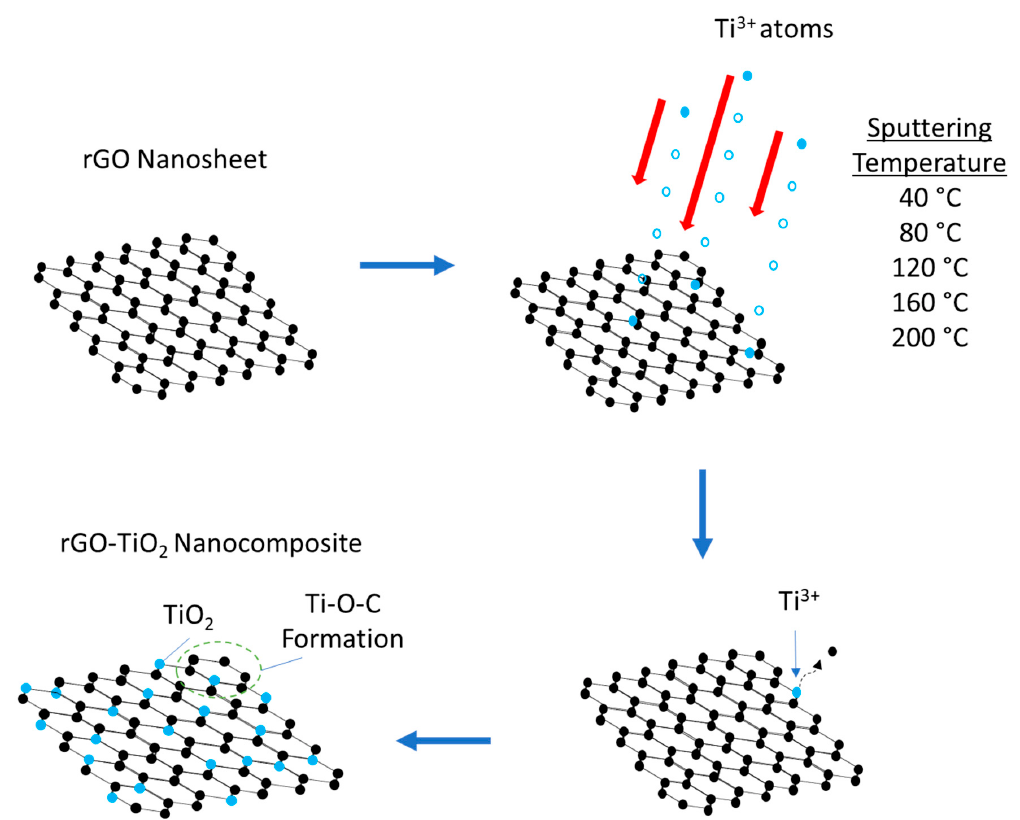
Figure 2. Sputtering mechanism process of rGO-TiO 2 nanocomposite.